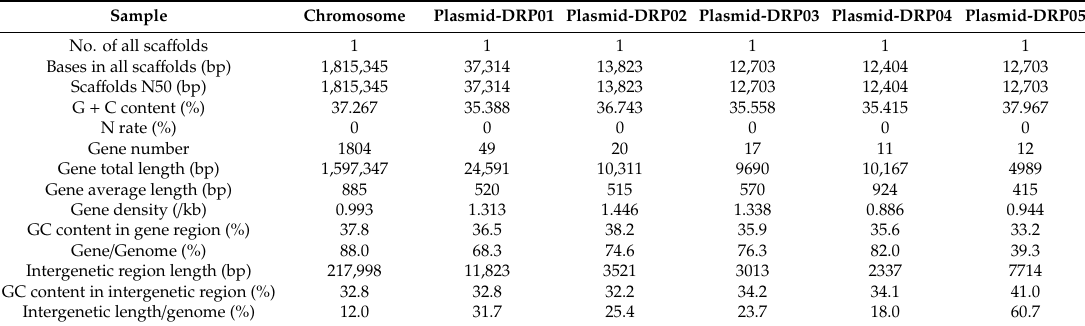
Table 2. Statistics table of the gene prediction information.